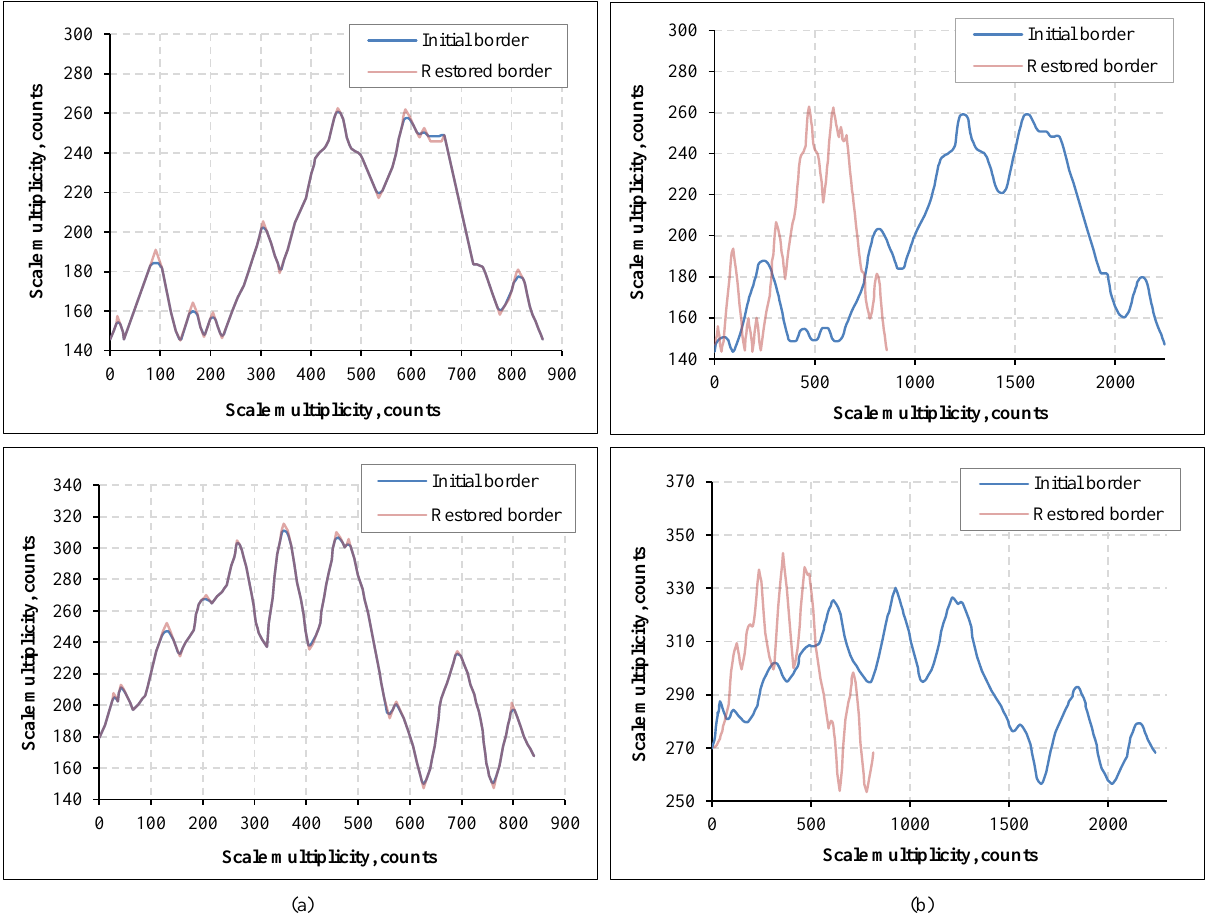
Figure 15. Parametric curves of the contour boundaries before modification (a) and after modification (b) To estimate the information loss when equating a part of descriptors to zero, it is necessary to compare the initial contour, and the contour restored using a limited set of descriptors by a specific criterion. Illustrative examples of initial parametric curves and restored ones using M descriptors are shown in Figure 16.